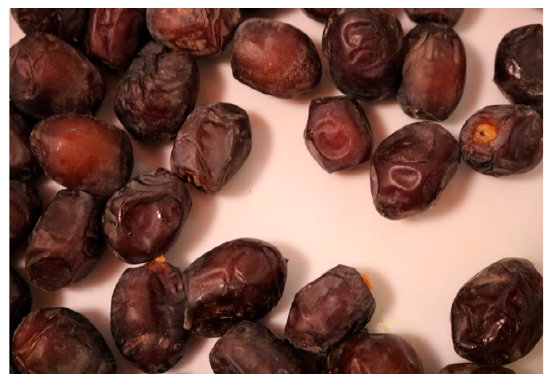
Figure 10. Sample of Al-kelas dates.